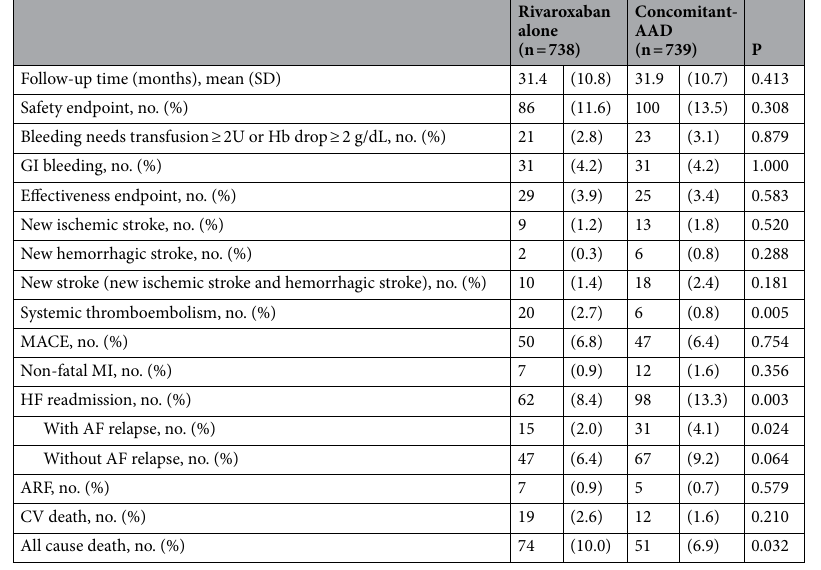
Table 2. Bleeding and clinical events of atrial fibrillation patients receiving rivaroxaban with and without anti-arrhythmic drugs in the propensity score-matched analysis. Effectiveness endpoint: new ischemic stroke, ICH, or embolism. Safety endpoint (by ISTH definition): Hb fall ≥ 2 g/dL or transfusion ≥ 2 U PRBC, critical site bleeding, or fatal bleeding. AF, Atrial fibrillation; MACE, CV death; MI, new ischemic stroke, embolism, or